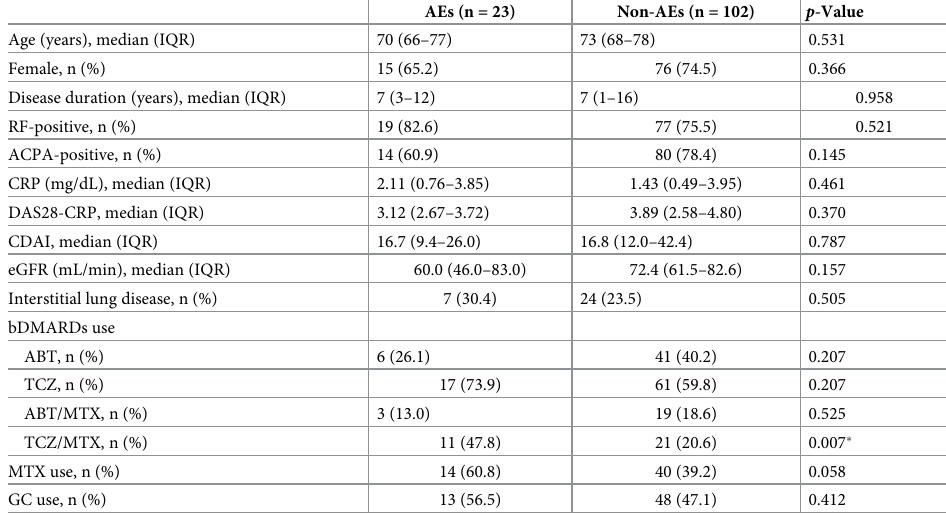
Fig 6. The cumulative incidences of discontinuation of ABT or TCZ due to adverse. There were no significant differences in the incidences of drug discontinuation due to AEs between ABT and TCZ groups. https://doi.org/10.1371/journal.pone.0274775.g006 Table 3. Baseline characteristics of elderly RA patients with the discontinuation of bDMARDs due to